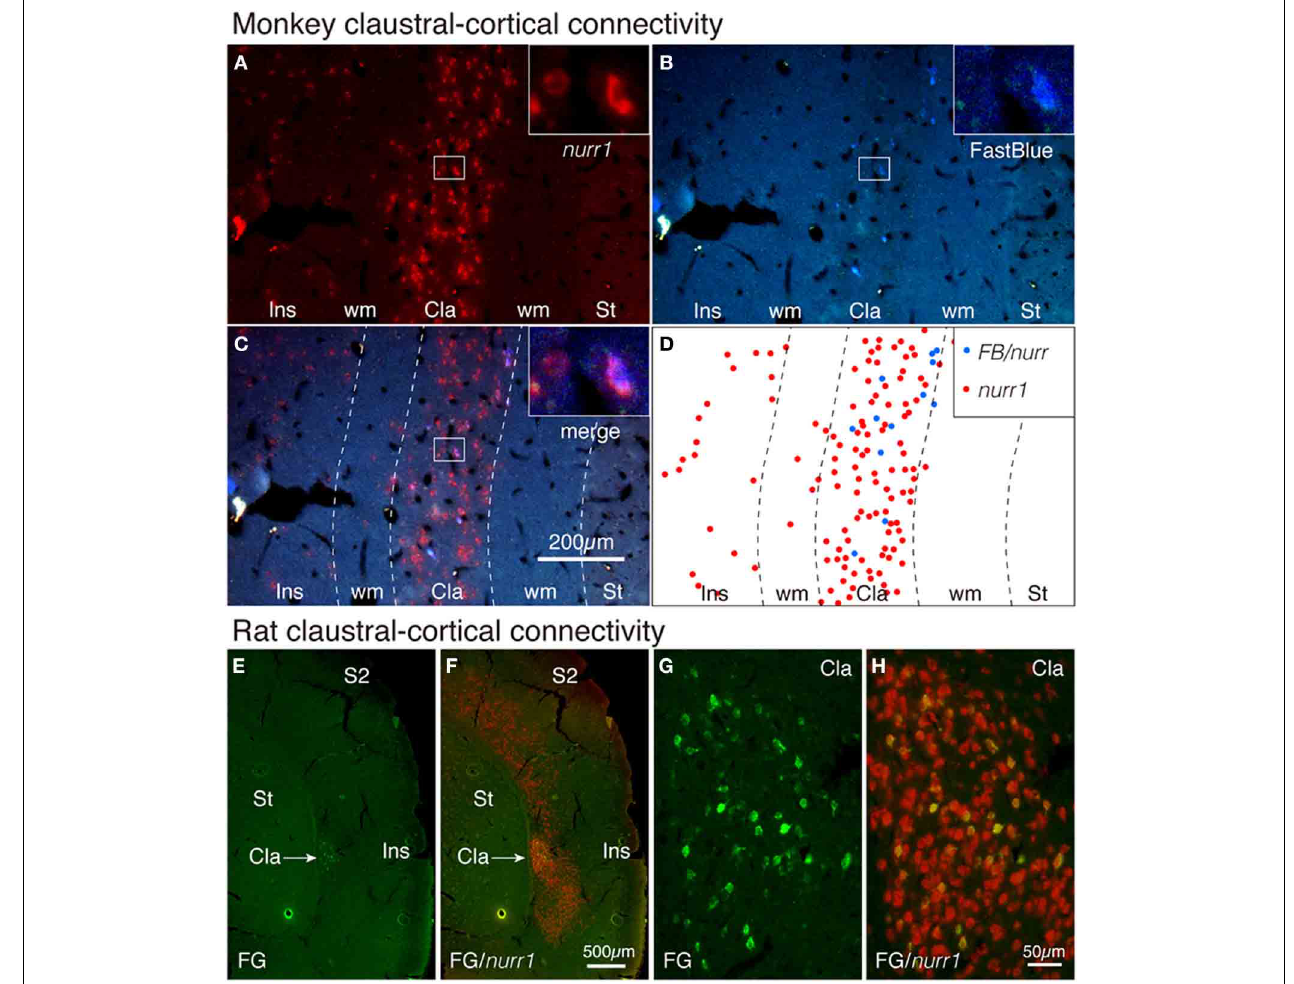
FIGURE 5 | Tracer-ISH of monkey and rat claustrum. (A–D) FastBlue was injected into areas V4 and 7a and several claustral cells were retrogradely labeled (B,D) . The same section processed for nurr1 ISH (A,C) exhibited nurr1 expression in all the FastBlue-labeled cells (see the insets). The rectangles within the claustrum are shown magnified in the insets for each panel. (D) indicate the schematic plot for (C) ; the nurr1